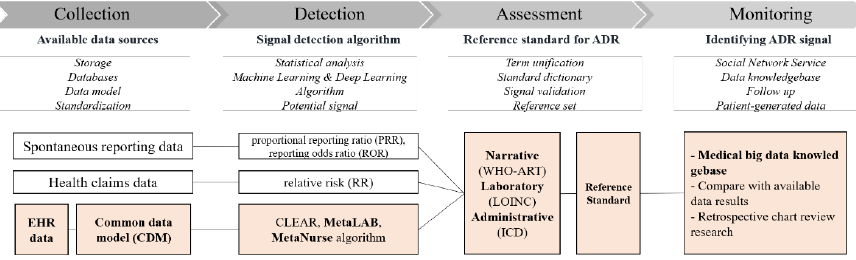
Figure 2. Collection, detection, assessment, and monitoring processes in pharmacovigilance systems.